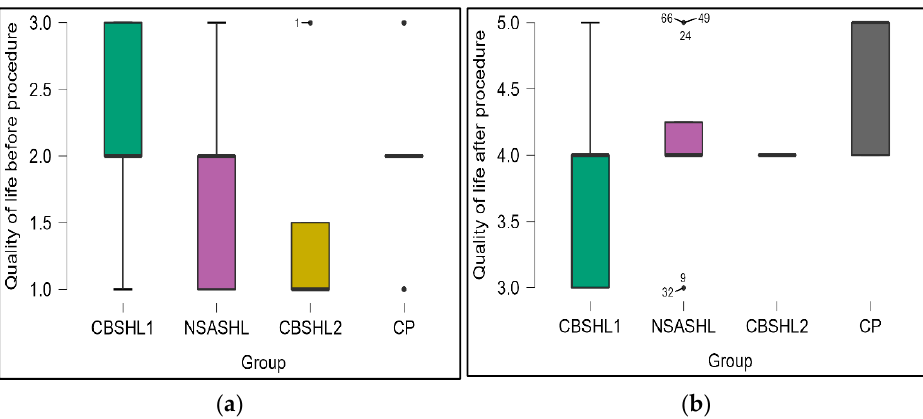
Figure 3. Quality of life assessment using the WHO WHOQOL-BREF (the mental domain). Quality of life re fl ects the adults’ view and the family’s view about the impact of treatment for their children: